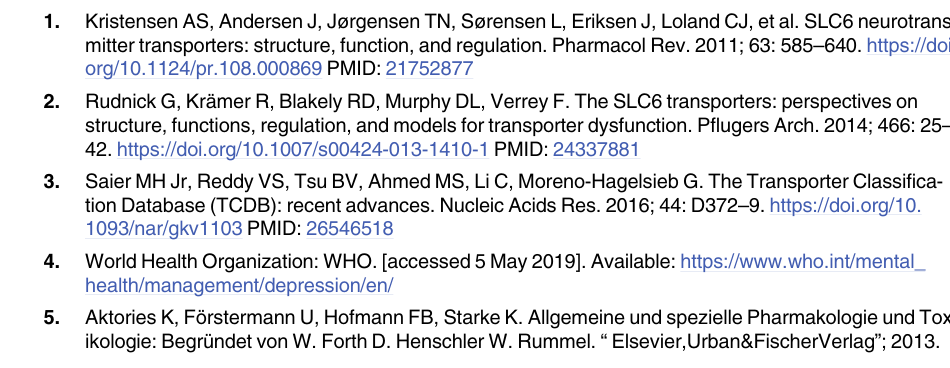
S1 Fig. Water counts in the intracellular vestibule as a function of simulation time. Num- ber of waters in the intracellular vestibule during molecular dynamics simulations of hSERT, as a function of time. The plots show the underlying data for the outward-open (left) and out- ward-occluded (right) trajectories used to plot the distribution of the intracellular water counts in Fig 10A of the main manuscript. S2 Fig. Coordination of chloride ions in simulations of the outward-open conformation. Distance of the chloride ion from its initial position during the simulations of the outward- open model. The protein was least squares fitted to the initial frame of each of four replicas.